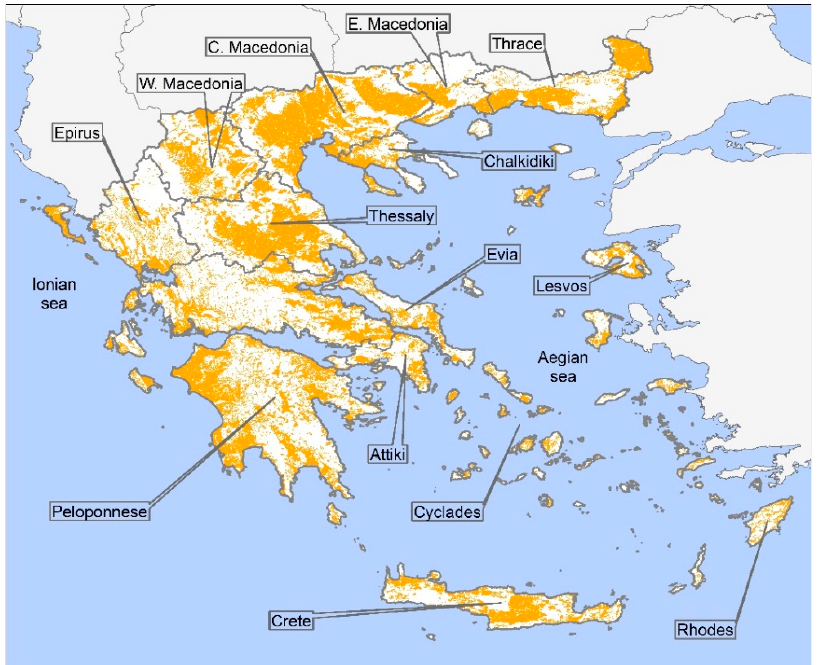
Figure 2. Regions of particular interest of the country for discussion. Agricultural areas are depicted in orange color.